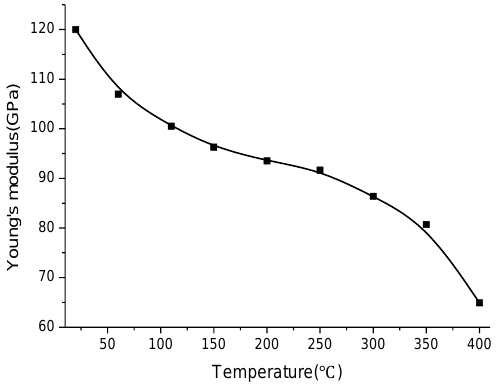
Figure 8. Calculated Young’s modulus of LTCC at different temperatures.